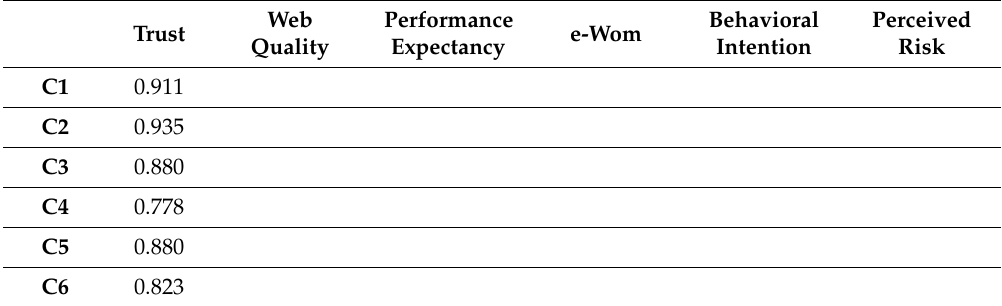
Table 2. Individual reliability of measurement scales (factorial